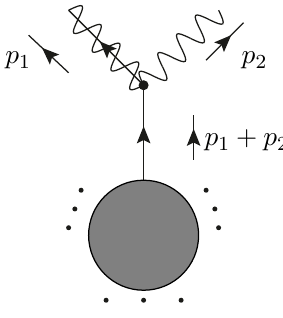
Figure 15 . Feynman diagrams leading to collinear gaugino and graviton singularities.